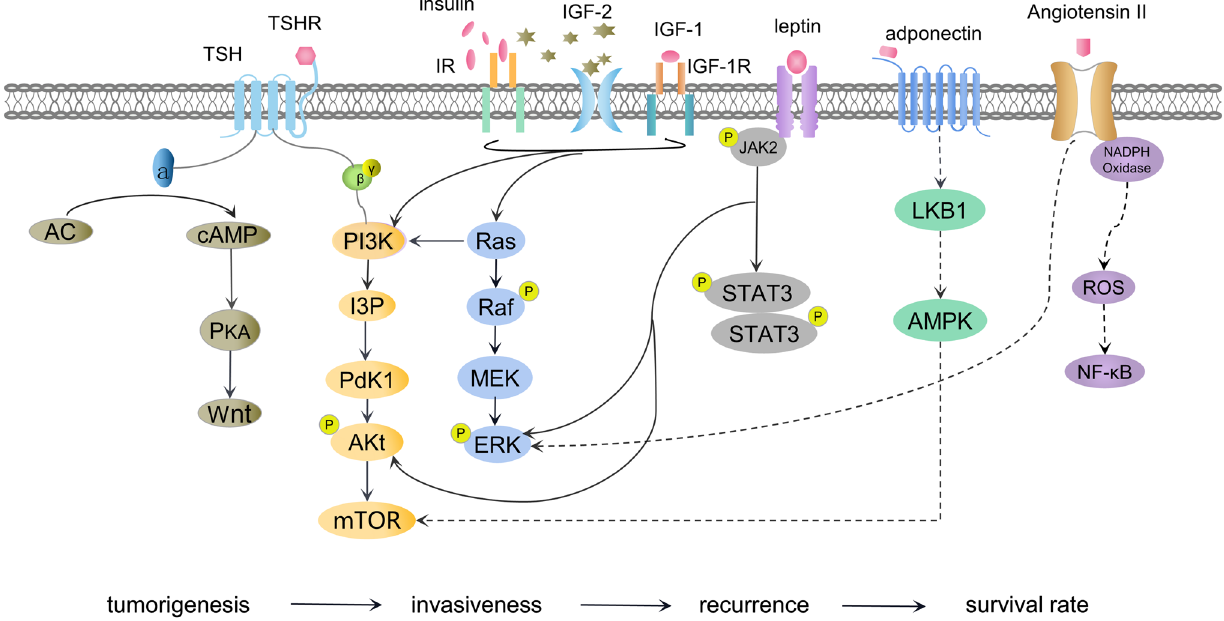
Fig. 1 Mechanistic network of metabolic syndrome and thyroid cancer. TSH thyroid stimulating hormone, TSHR thyroid stimulating hor- mone receptor, IR insulin receptor, IGF insulin-like growth